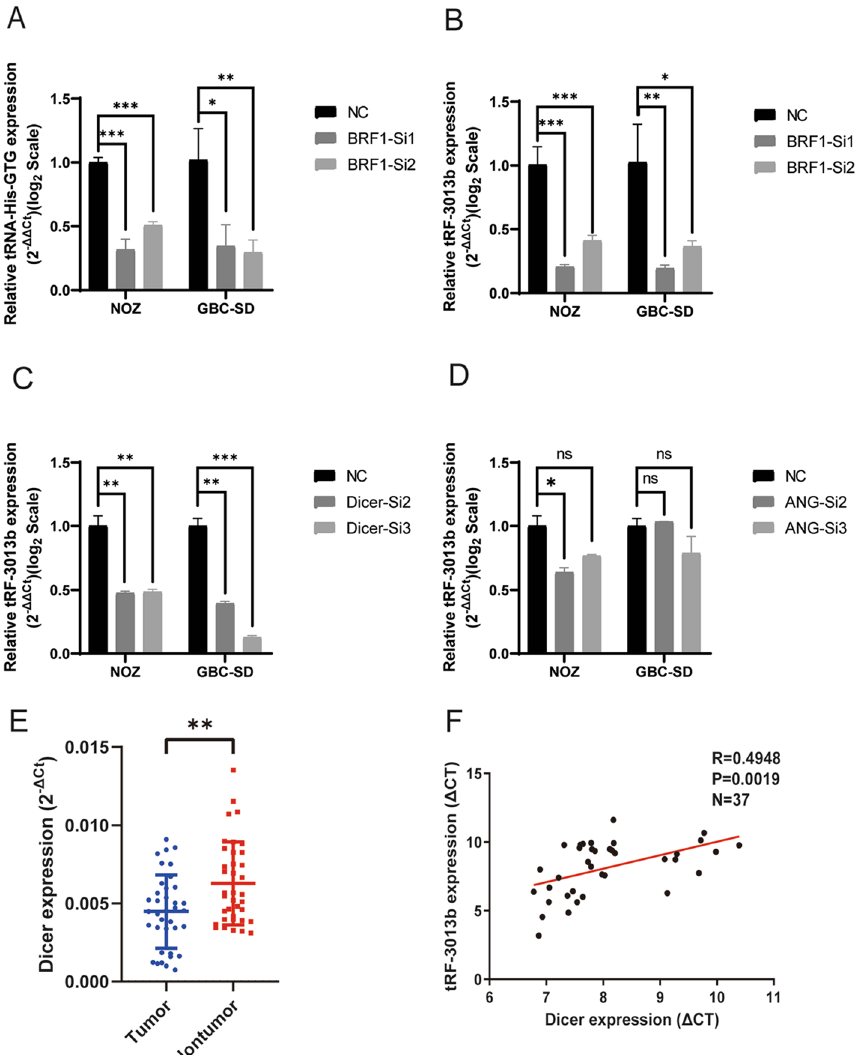
Fig. 2 Dicer induced production of tRF-3013b in GBC cells. A Expression of tRNA-His-GTG in GBC cells with BRF1 knockdown. B Expression of tRF-3013b in GBC cells with BRF1 knockdown. C Expression of tRF-3013b in GBC cells with Dicer knockdown. D Expression of tRF-3013b in GBC cells with ANG knockdown. E Dicer expression level in 37 pairs of GBC and para-cancer tissues. F Linear regression analysis and paired t -test for determining the correlation between the expression levels of tRF-3013b and Dicer. ns P > 0.05, * P < 0.05, ** P < 0.01, *** P <